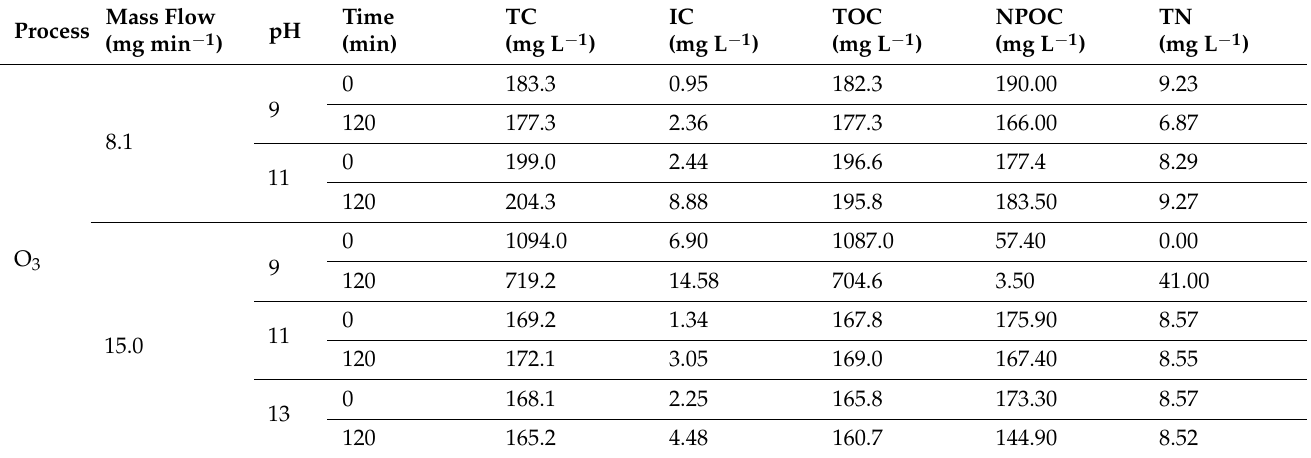
Table 1. Analyses of carbon and nitrogen elements in the O 3 -based oxidation of AMX. Total